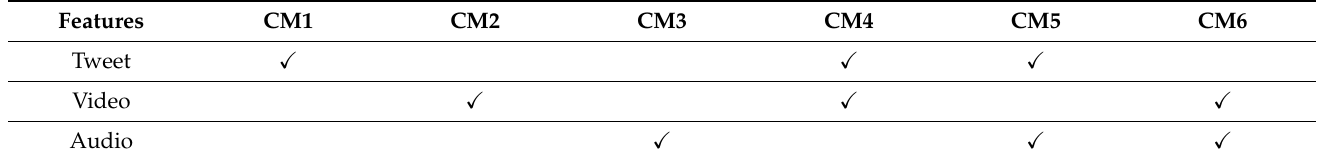
Table 2. Features used in Comparative Methods (CMs)